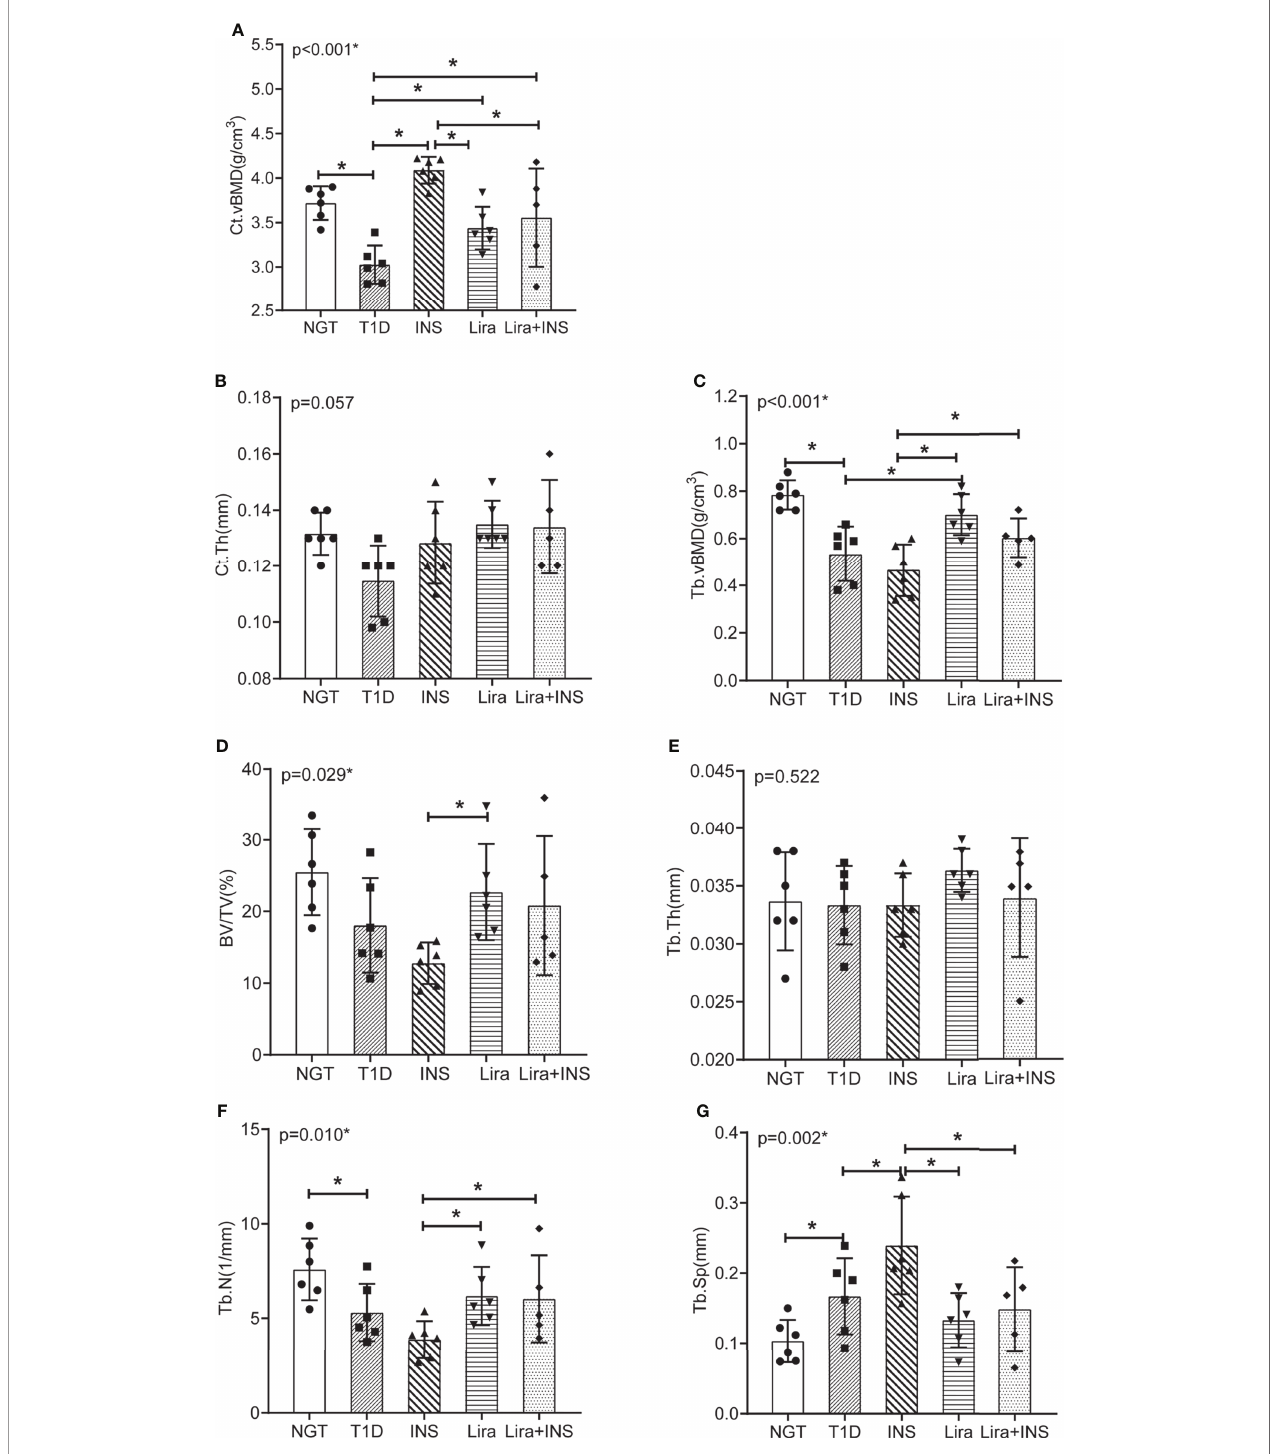
FIGURE 3 | Bone mineral density and microarchitectures of tibia measured by micro-CT. (A) Cortical volumetric bone mineral density (Ct.vBMD); (B) cortical bone thickness (Ct.Th); (C) trabecular volumetric bone mineral density (Tb.vBMD); (D) bone volume fraction (BV/TV); (E) trabecular thickness (Tb.Th); (F) trabecular number (Tb.N); (G) trabecular separation (Tb.Sp). NGT, normal glucose tolerance group; T1D, type 1 diabetes group; INS, insulin treatment group; Lira, liraglutide treatment group; INS+Lira, insulin + liraglutide treatment group. ANOVA was used for comparison between groups, and p < 0.05 was de fi ned as statistically signi fi cant. *was used to indicate statistical difference. All data are expressed as mean ±